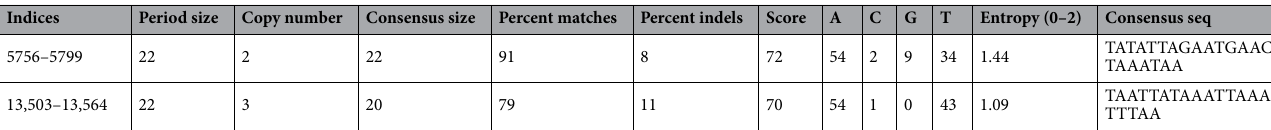
Table 7. Tandem repeats in the mitogenome of O.